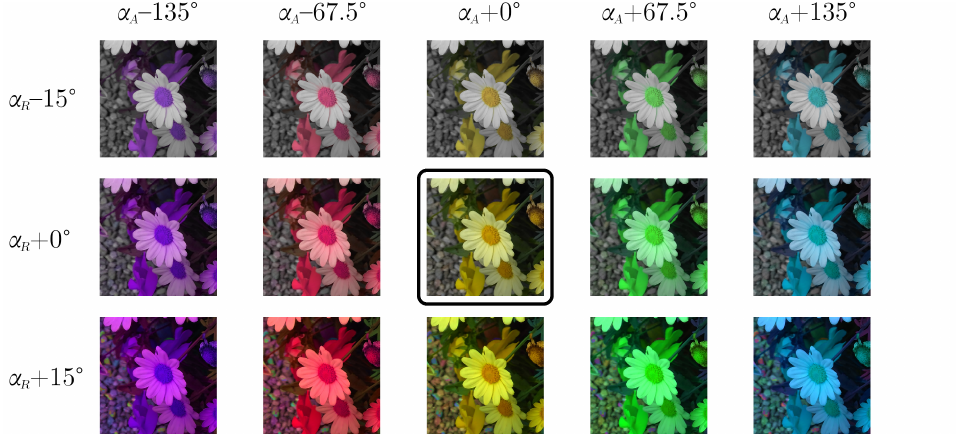
Figure 2. Visualization of how modifying ARC chromatic components α A and α R impacts the reconstructed RGB image. Original image in the middle